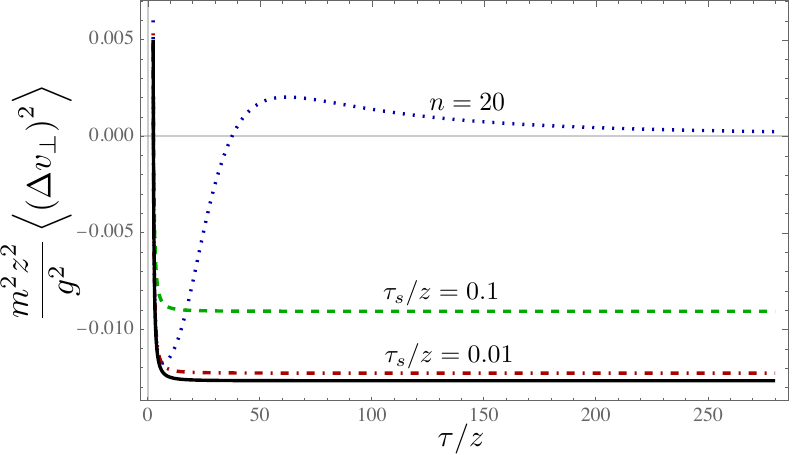
Figure 4 . Late time behavior of the dispersion of perpendicular component of the particle velocity when the switching F ( n ) (cid:28) ( t ) is implemented (dotted curve), and when the alternative switching F (cid:28) ( t ) is implemented (dashed and dot-dashed curves). The solid curve describes the sudden s ;(cid:28) switching. The curves start at (cid:28)=z = 2 : 4 in this